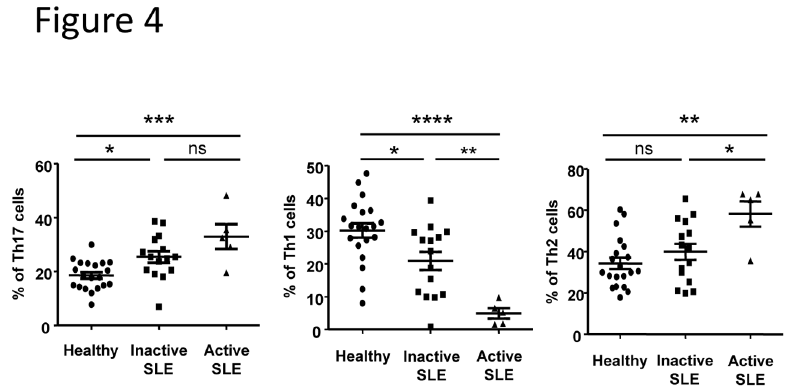
Figure 4. Th cell subset distribution is altered in SLE patients. Th cell subset frequencies were determined according to the expression of CXCR3 and CCR6 on CD4 + CD45RA - CXCR5 - T cells. The frequency of each Th cell subset was defined in samples from inactive SLE patients (n = 13), active SLE patients (n = 6) and sex and age-matched healthy controls (n = 19). Results are expressed as the mean ± sem. * p < 0.05, ** p < 0.01, *** p < 0.001 (one-way ANOVA test). ns: not significant.